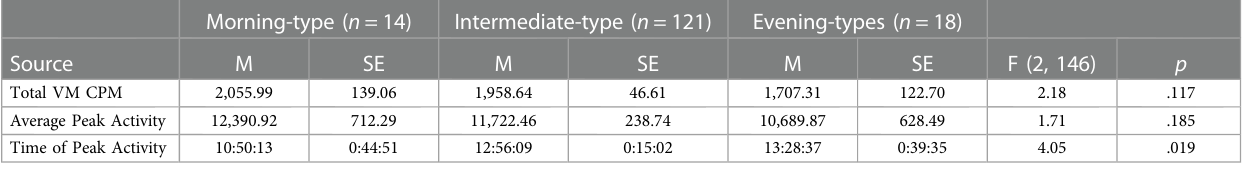
TABLE 2 Chronotype group differences in total activity, peak activity, and time of peak activity ( N =153).